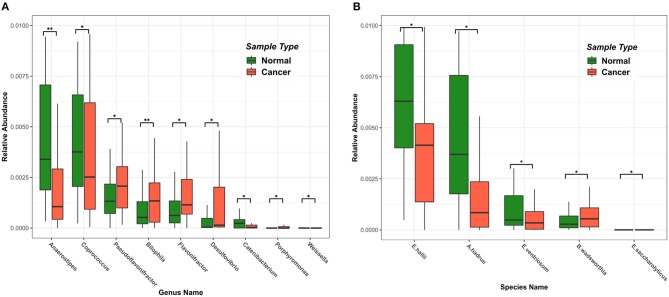
Differences in intestinal microbiome at the genus and species level among samples of different states. Green represents a healthy sample, and red represents a colorectal cancer sample. (A) The top nine microbial genera with significant differences in abundance. (B) The top five microbial strains with significant differences in abundance.